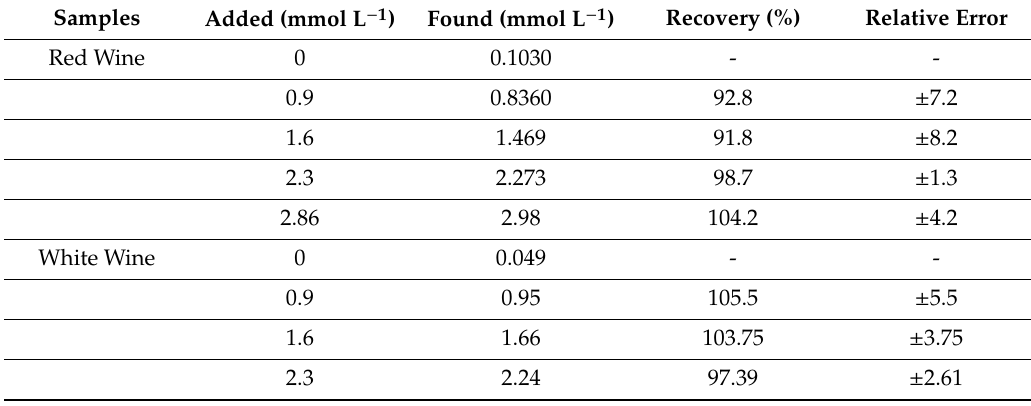
Figure 17. DPV voltammograms show the determination of gallic acid in a real sample of red wines; (Inset) calibration graph created using the analysis of the real sample. Table 3. Results of the analysis of GA in the spiked red and white wine.